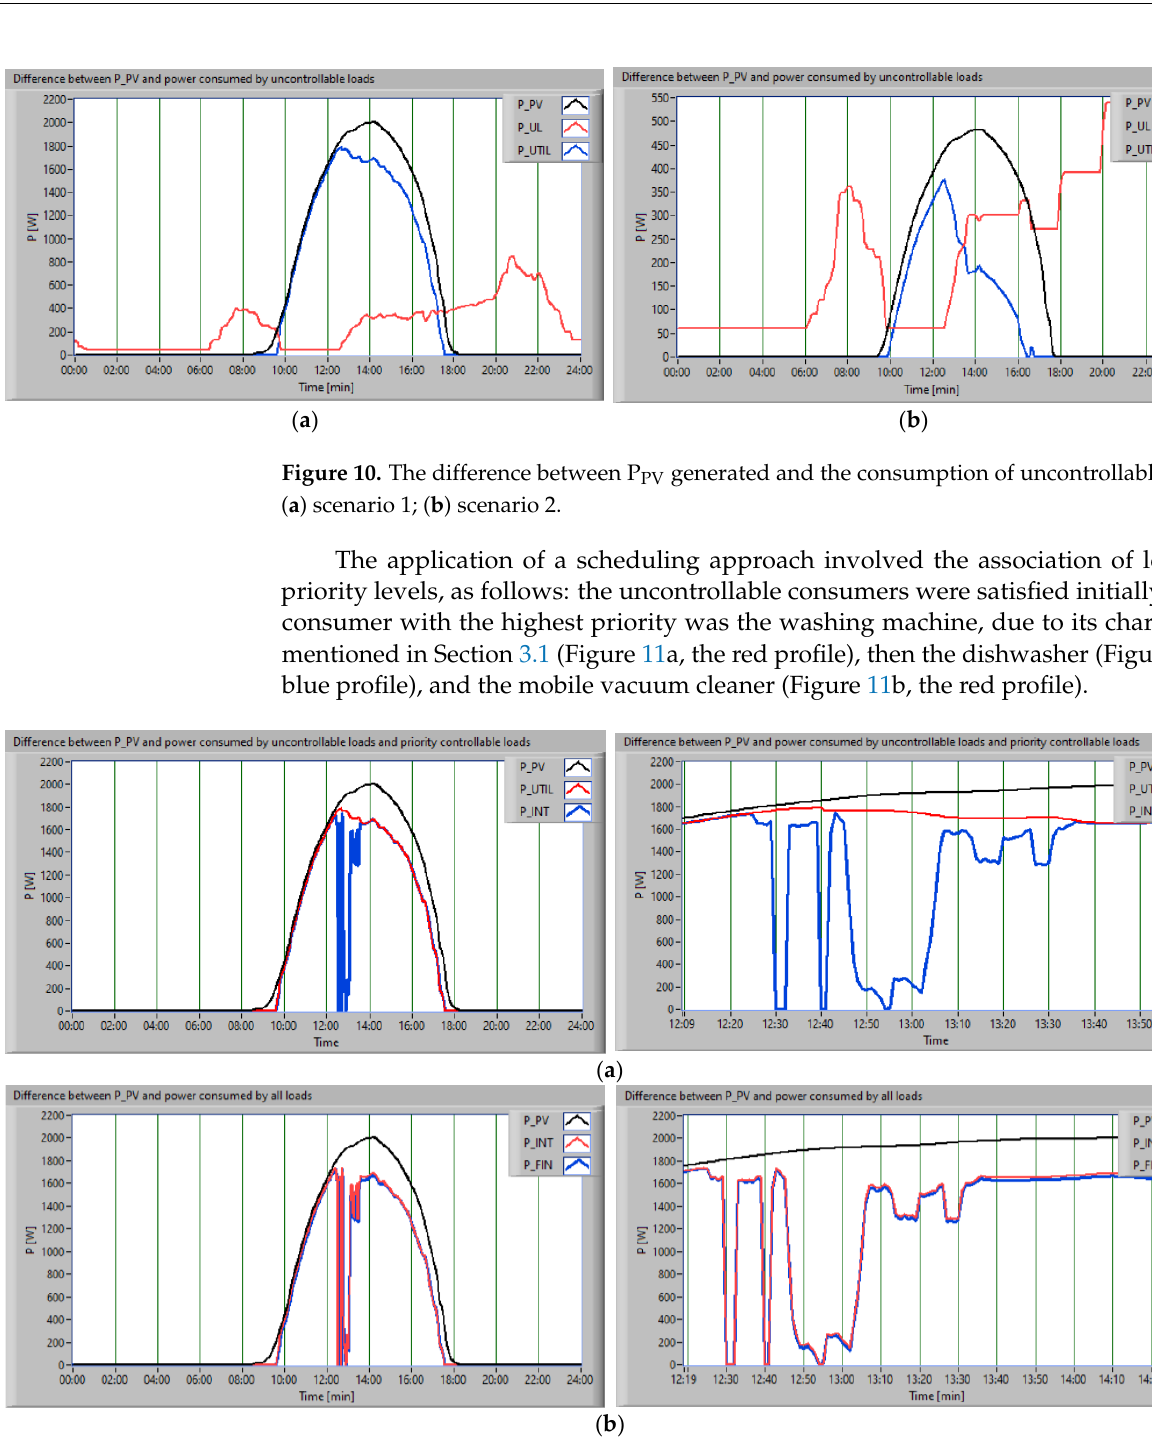
( b ) Figure 9. FIS – FCM error evolution with iterations in the ( a ) training and ( b ) testing phases. 4.3. Scheduling of Loads for Optimal Use of Energy This part is dedicated to the implementation and analysis of the proposed approach related to the scheduling algorithm. For this proposition, the reference consisted of avail- able data sets that were relevant to the amounts of energy produced from RES: the 2 February 2023 (scenario 1), and the 5 January 2023 (scenario 2). In both scenarios, the identified load profile with the neuro-fuzzy knowledge-based system and the energy generated by the RES were considered to be references. From the analysis of the consumption profiles associated with uncontrollable con- sumers (P UL ) and that of the energy produced from RES (P PV ), a gap could be observed between the moment when the energy was produced and the real initial behavior of the consumers, in the absence of scheduling. The difference (P util ) was more evident in the case of the second scenario, when the amount of energy produced was smaller (Equation (10)).